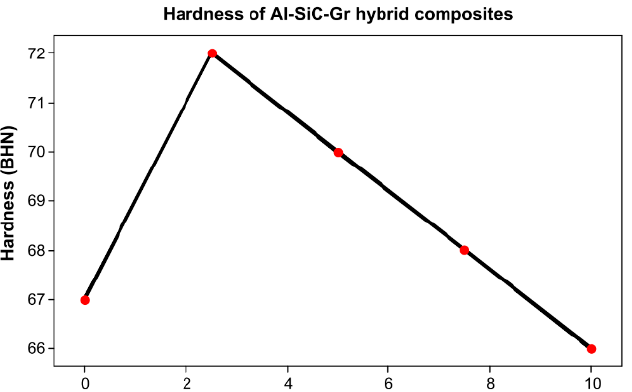
Figure 17. Effect of reinforcement content on Al–SiC–Gr hybrid composite hardness [96]. Mohanavel [97] investigated the mechanical properties of AA6351 composites re- inforced with Al 2 O 3 and Gr. The hardness of the AA6351 base matrix alloy increased as reinforcement increased. After the dispersion of Al 2 O 3 /Gr particles, the mechanical characteristics of the AA6351 alloy were greatly